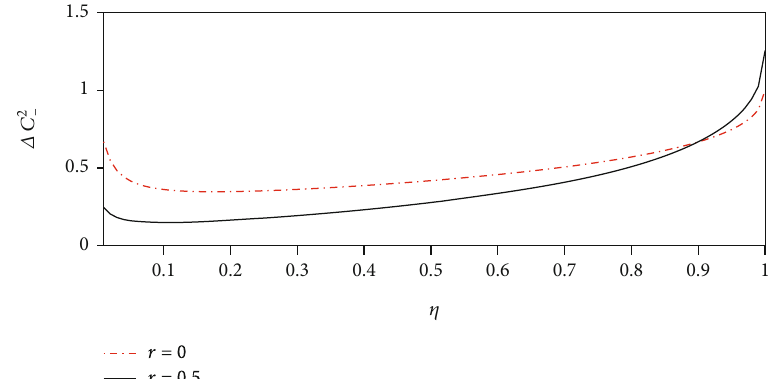
Figure 2: Plots of minus quadrature variances (Equation (25)) versus η for A = 100 and κ = 0 : 8 and for di ff erent values of squeeze parameter.